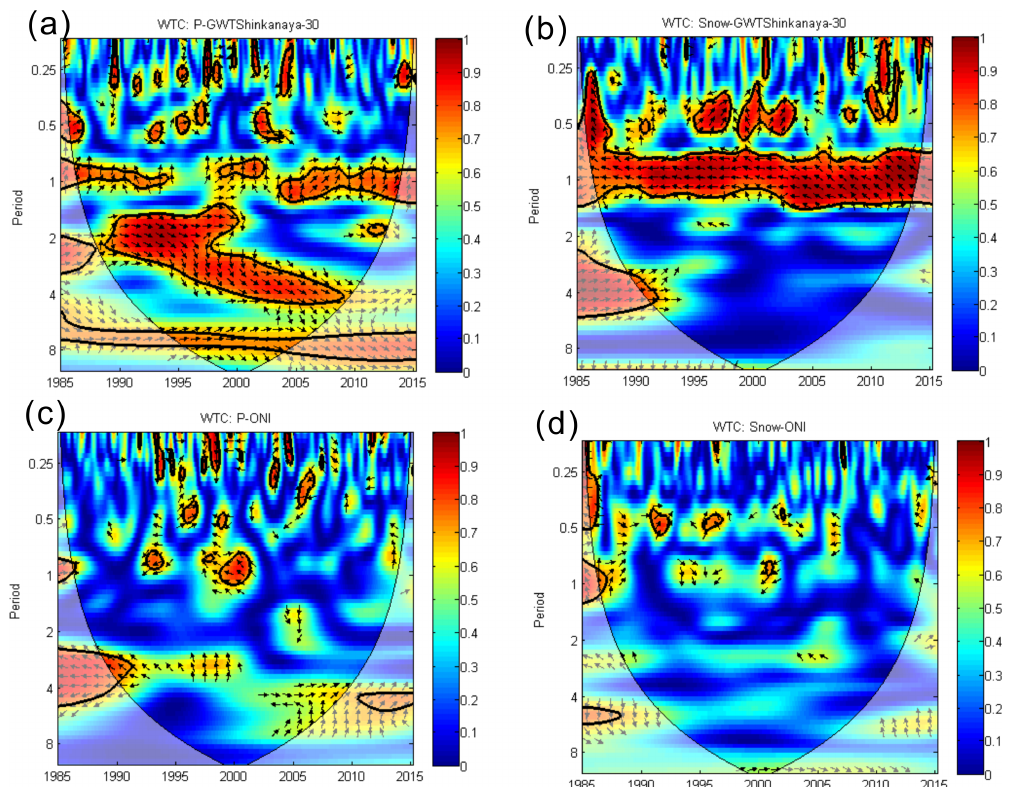
Figure 3. Squared wavelet coherence between rainfall and groundwater table (a) , snowfall and groundwater table (b) , rainfall and the ONI (c) , and snowfall and the ONI (d)